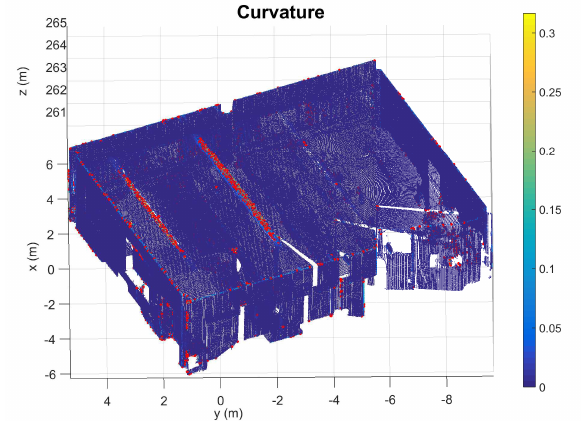
Figure 8. Classroom point cloud keypoints (red) from the curva- ture values.